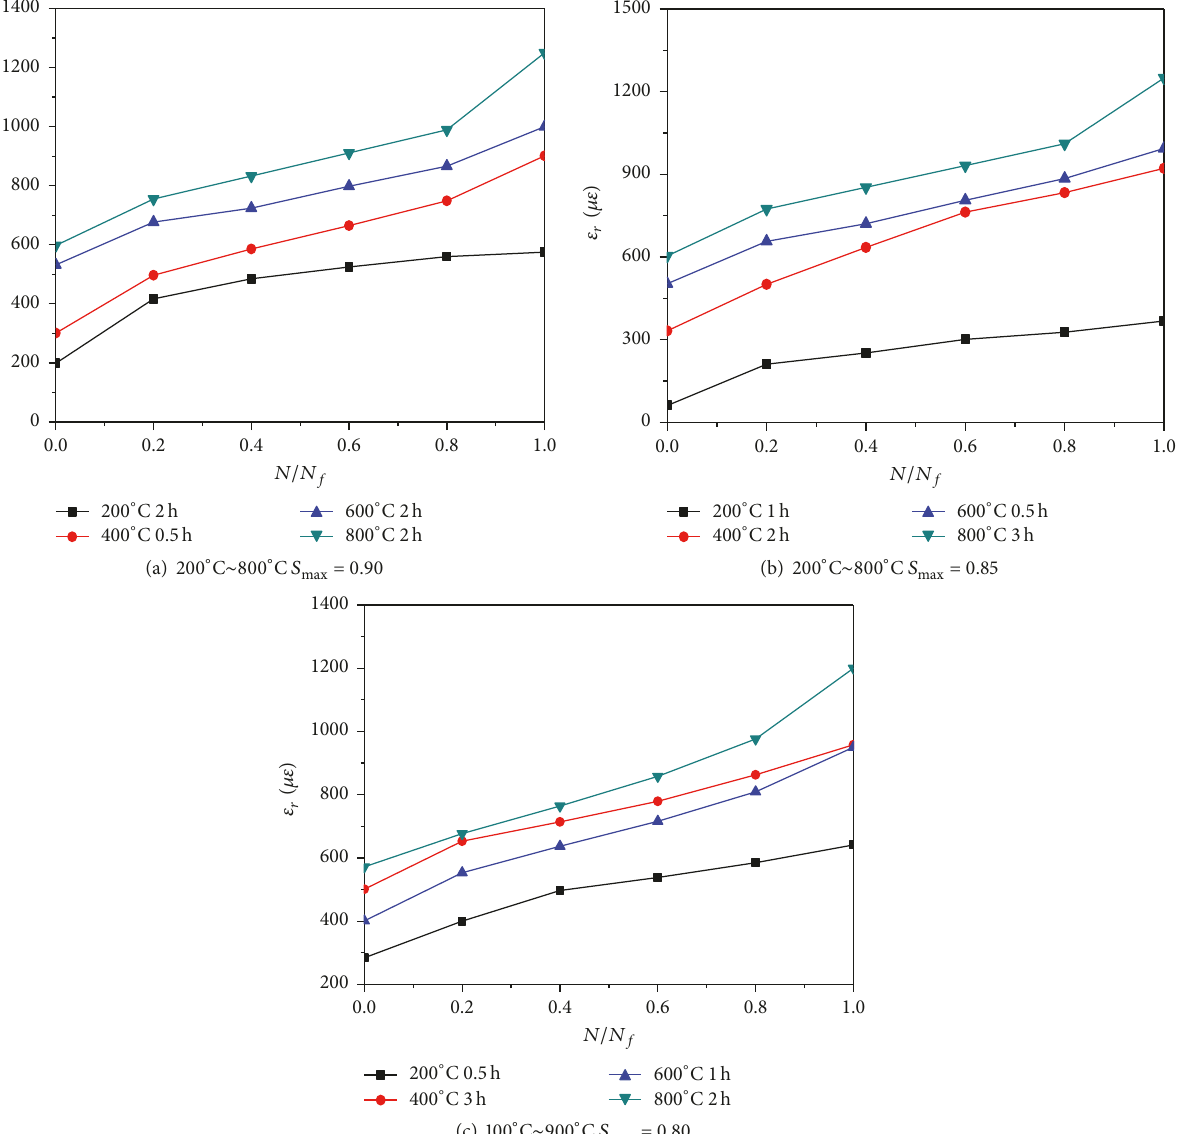
Figure 5: Relationship between the fatigue residual strain, holding time 𝑡 , and high temperature 𝑇